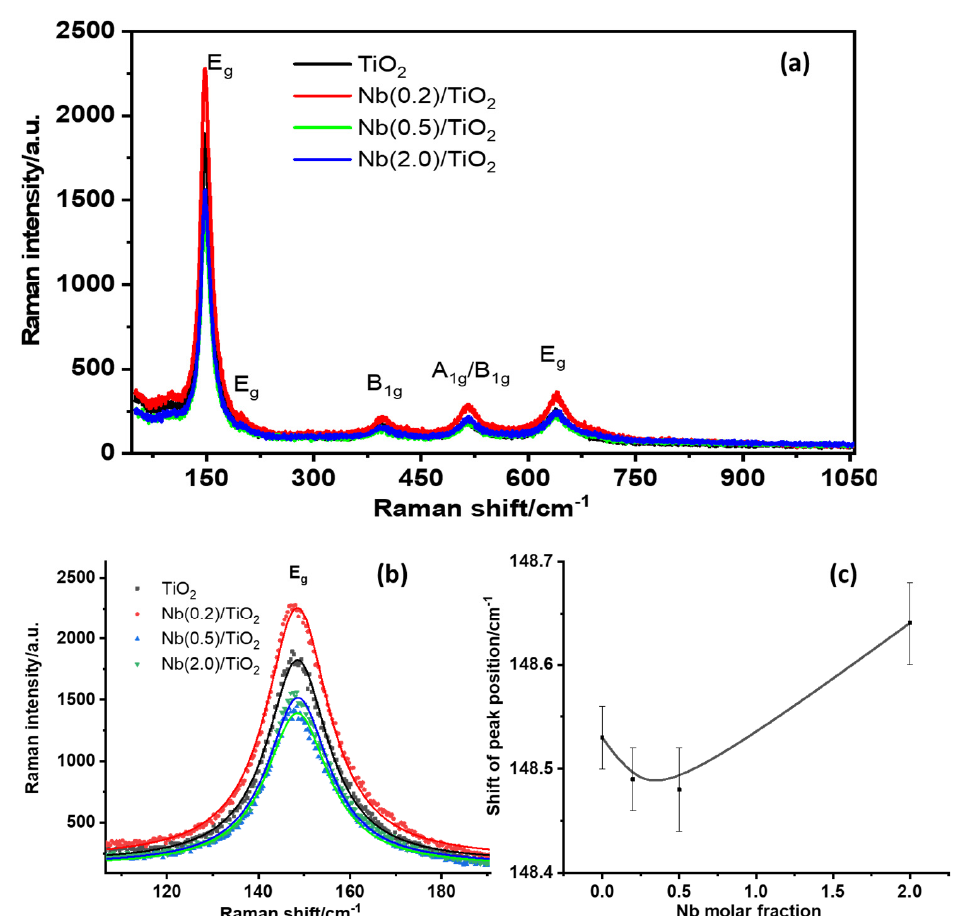
Figure 4. ( a ) Room-temperature Raman spectra of pure TiO 2 and Nb(x)/TiO 2 nanocomposites. ( b ) Fitting of the E g mode with a Lorentzian function of Pure TiO 2 , Nb(0.2)/TiO 2 , Nb(0.5)/TiO 2 , and Nb(2.0)/TiO 2 . ( c ) Variation of the E g mode position versus the molar fraction of Nb.